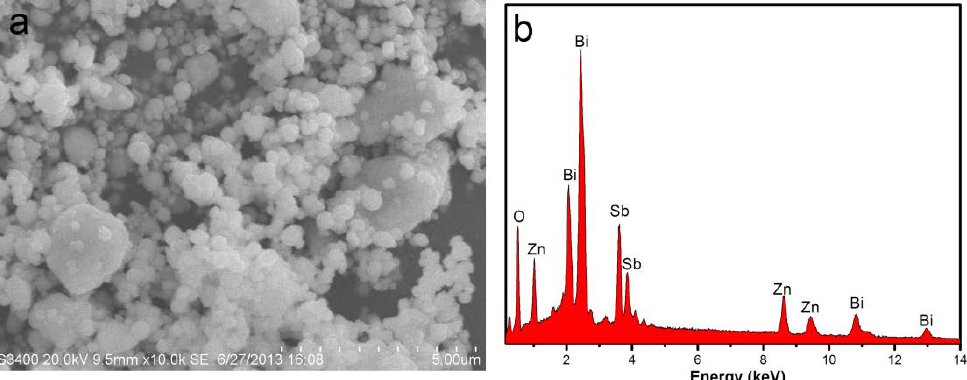
; ( b ) energy-dispersive 4 calcinated at 800 °C for 35 h. 4